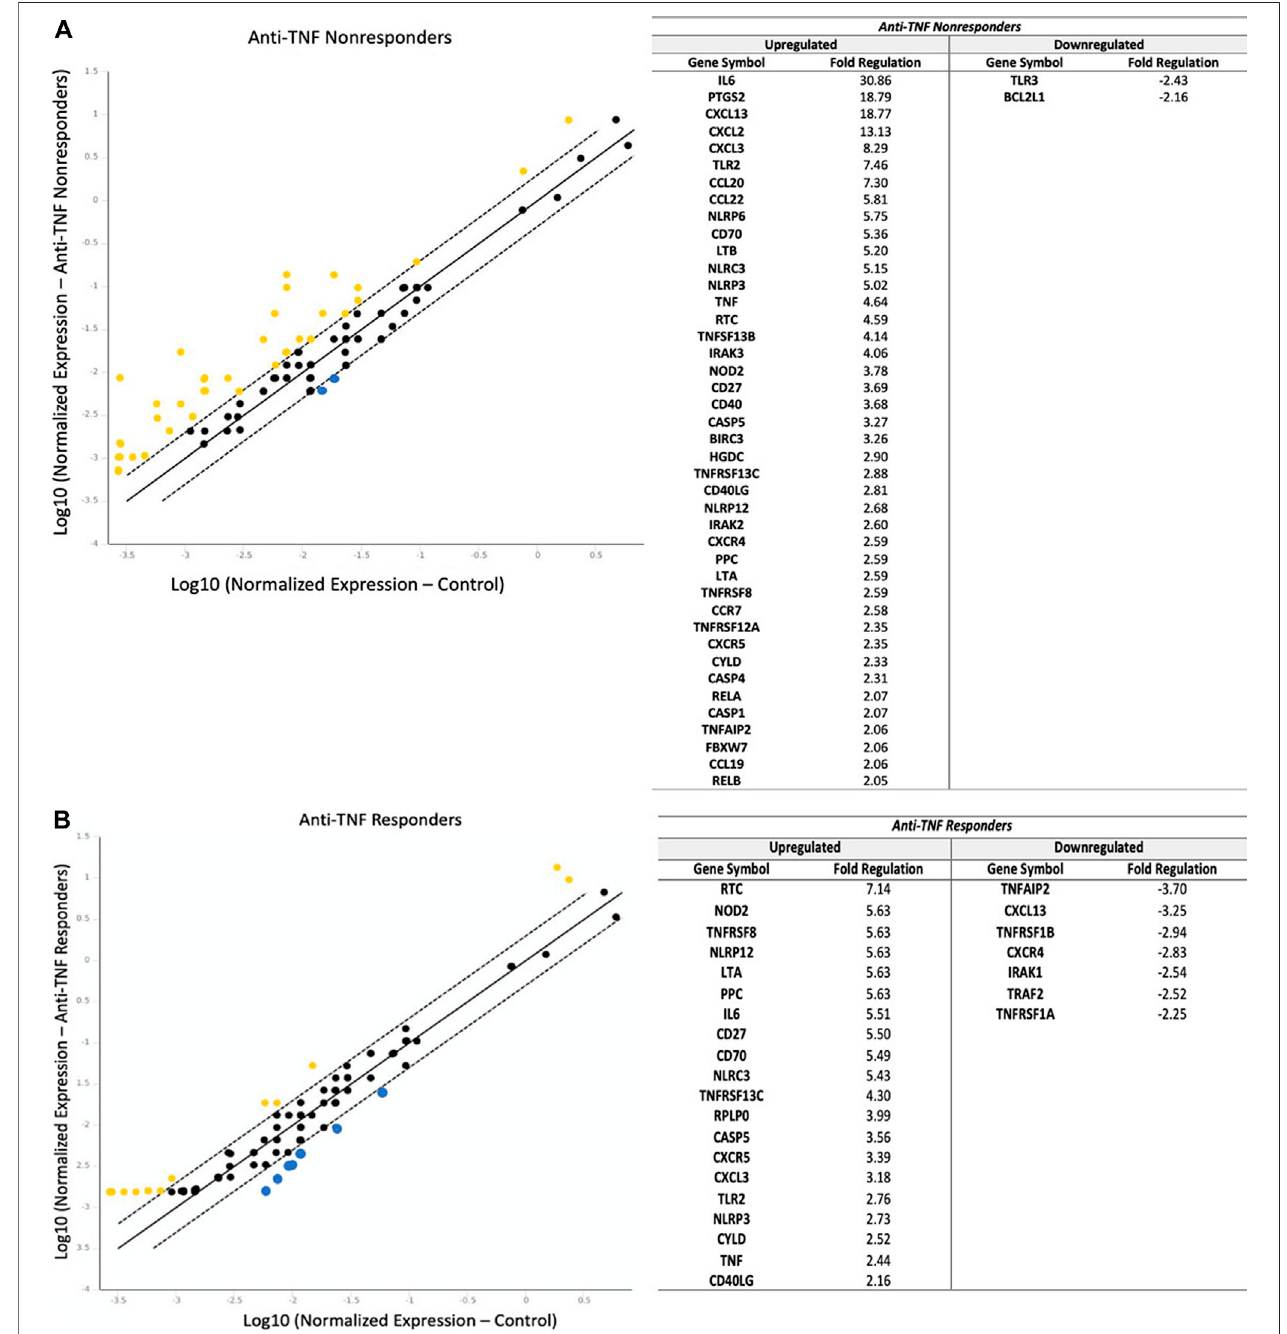
FIGURE 2 | Noncanonical NF- κ B is Downregulated in IBD Patients Responding To Anti-TNF Therapy. (A) : In fl amed tissues from anti-TNF nonresponders ( n (cid:2) 10, twopools,CDpatientsandUCpatients)showed39upregulatedgenesrelatedtothenoncanonicalNF- κ Bsignaling,comparedtoonly19genesinanti-TNFresponders ( n (cid:2) 5, twopools) (B) , with yellow indicatingupregulationand blue indicating downregulation (lines represent 1, 0,and − 1fold change; genesoutside ofdashed lines are consideredsigni fi cantlydysregulated).Alistoftheinvolvedgenesisprovidednexttoeachgraph.Housekeepinggenesusedfornormalizationinclude ACTB,B2M, and GADPH (C – F) :Ingenuity PathwayAnalysisrevealedthatnoncanonicalNF- κ Bwasasigni fi cantsignalinghubthatwasdownregulatedinpatientsrespondingtoanti- TNFtherapy. Expressionlevelsofthemainnoncanonicalgenes NIK(MAP3K14), CXCL12,CXCL13 ,and CCL21 wereupregulated inbothuntreated patients ( n (cid:2) 2,one pool) (C) andpatientstreatedwithnon-anti-TNFmedications( n (cid:2) 10,twopools) (D) .However,anti-TNF responders( n (cid:2) 5,twopools) (E) ,showedadistinctattenuation of expression of these genes. Meanwhile, anti-TNF non-responders showed upregulation of CXCL12 and CXCL13 and downregulation of CCL21 . Note: green represents downregulation; red represents